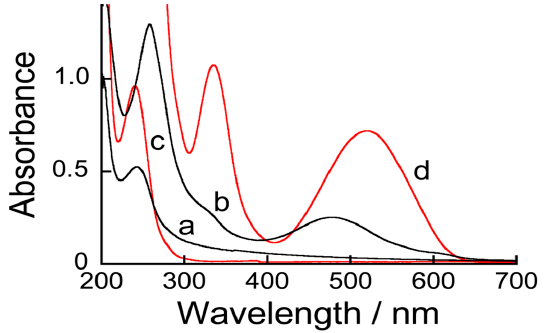
Figure 3. UV-visible absorption spectra of (PBA-PEI/CMC) 10 PBA-PEI film (a); ARS-immobilized (PBA-PEI/CMC) 10 PBA-PEI film (b); PBA-PEI (0.05 mg · mL − 1 ) (c) and ARS (0.1 mM) (d).